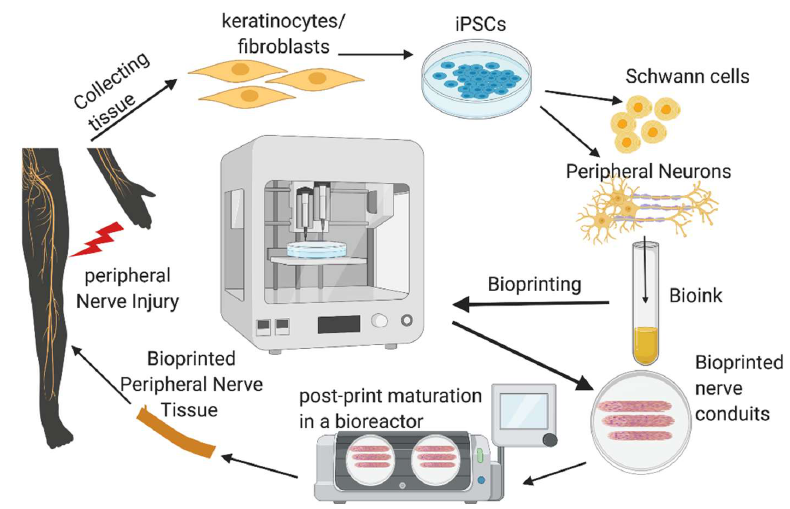
Figure 4. Bioprinting of nerve conduits. The peripheral cells, like keratinocytes or fibroblasts, are collected from the skin, and pluripotency is induced in these cells to make iPSCs. The iPSCs are differentiated to peripheral neurons or iPSC-cells as such will be suspended in the scaffold material to make the bioink. The nerve conduit would then be printed using a suitable bioprinter, post- processed and used for transplantation in the peripheral nerve injury site.